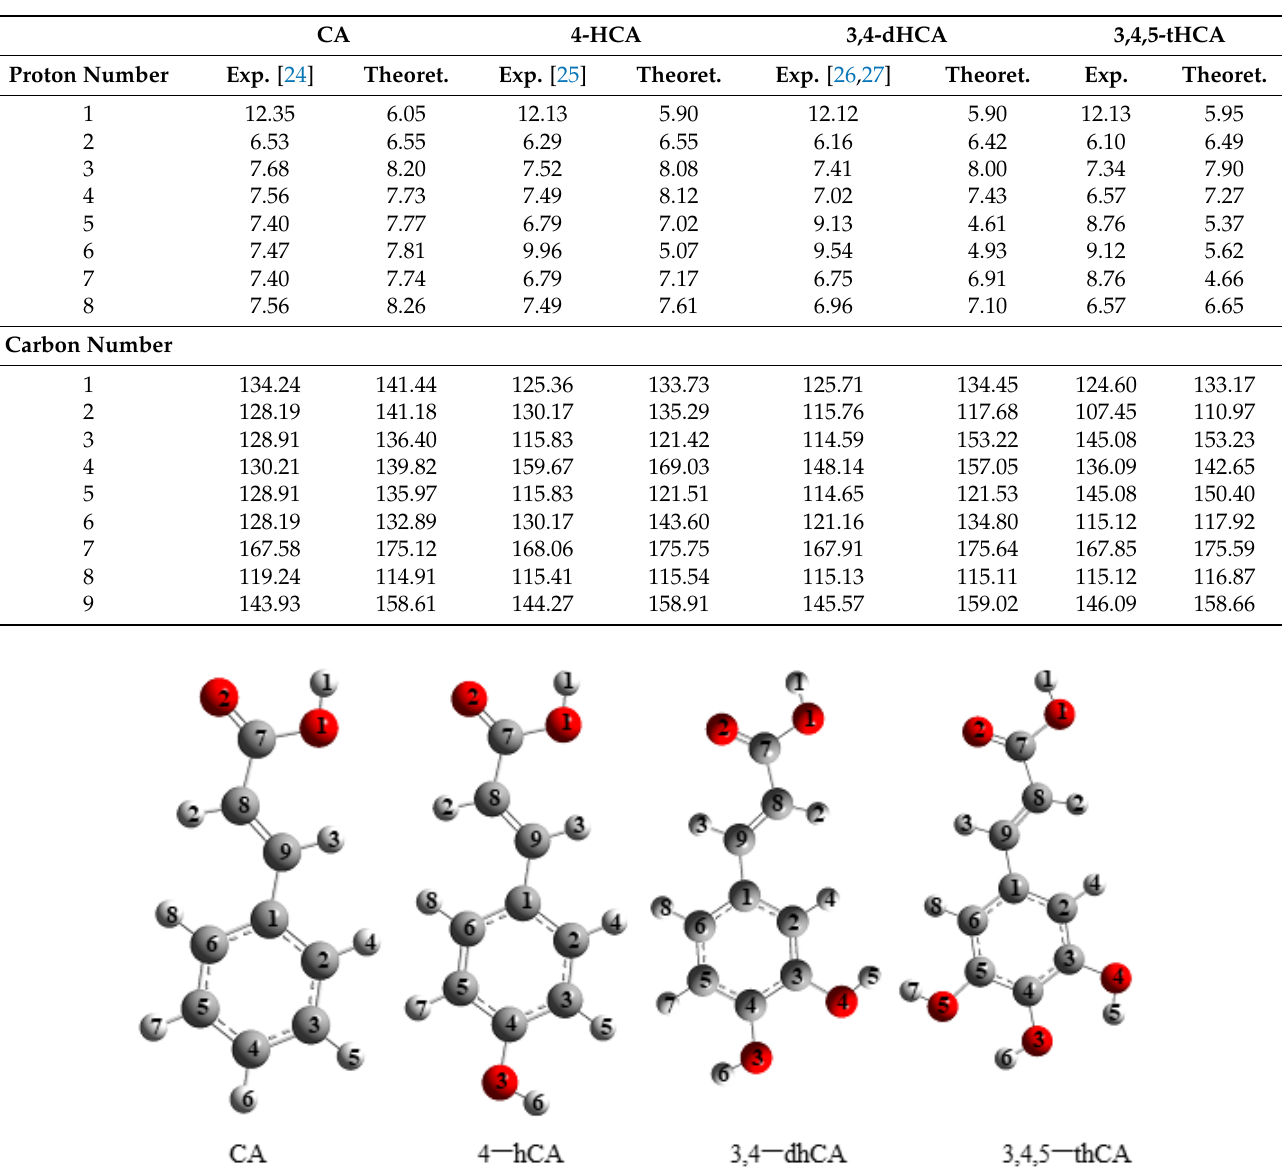
Table 3. Chemical shifts of CA; 4-HCA; 3,4-dHCA; and 3,4,5-tHCA in 1 H and 13 C NMR spectra [ppm]; atom numbering in Figure 3.